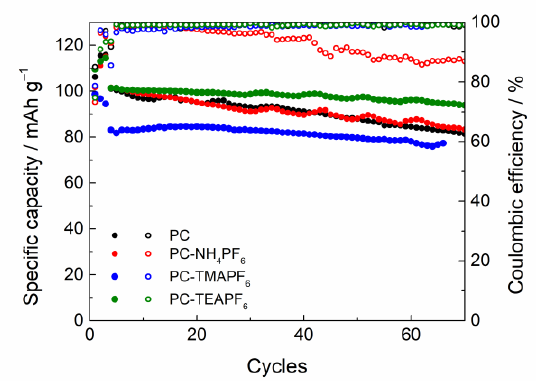
Figure A3. Capacity retention (full circles) and coulombic efficiency (plein circles) data of Li||NMC cells with PC and PC-NH 4 PF 6 electrolytes over testing at C/2, after two formation cycles at C/10 C- rate.